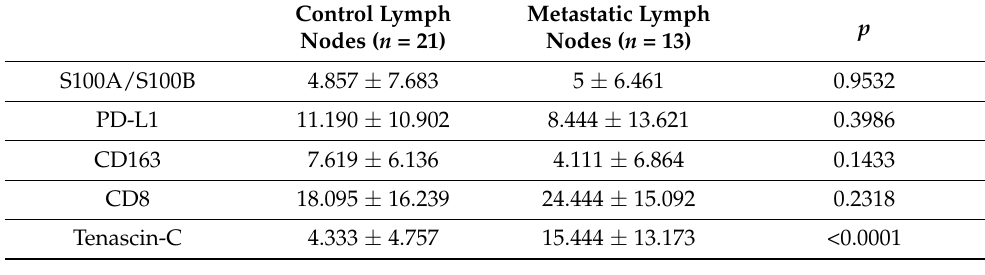
Table 5. Comparison between non-cancer-draining lymph nodes and metastatic lymph nodes.